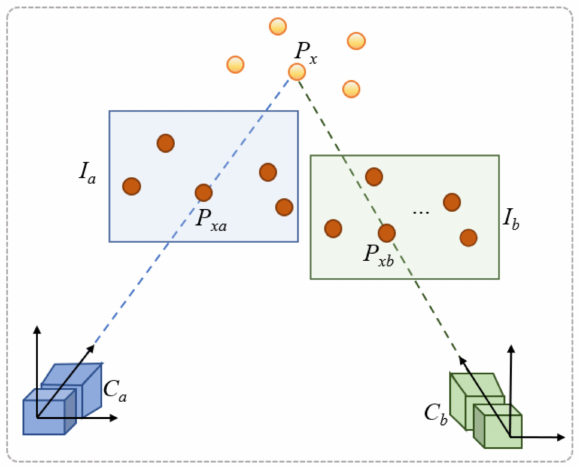
Figure 5. Estimation of transformation matrices between images I b and I a